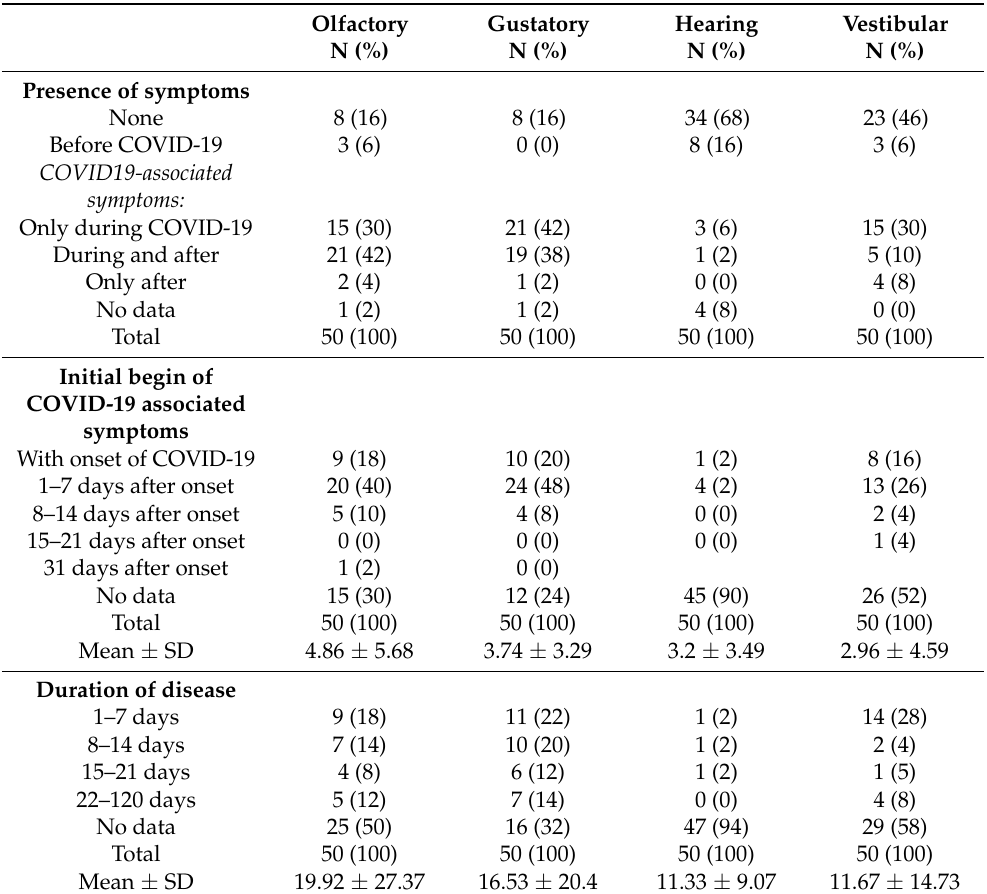
Table 2. Questionnaire data of sensory dysfunction during and after